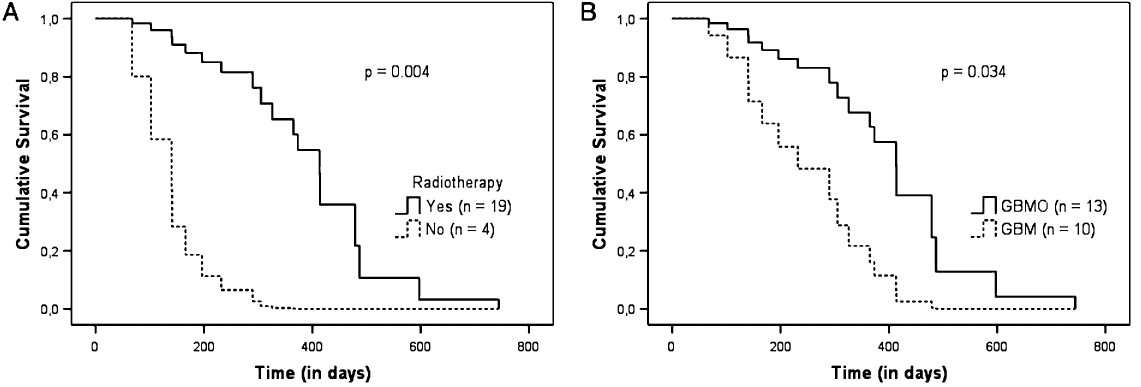
Fig. 5. Overall survival curves of glioblastoma patients (A) according to radiotherapy and (B) with or without oligodendroglial component. Abbreviations: GBMO – glioblastoma with oligodendroglial component; GBM – “classic” glioblastoma.